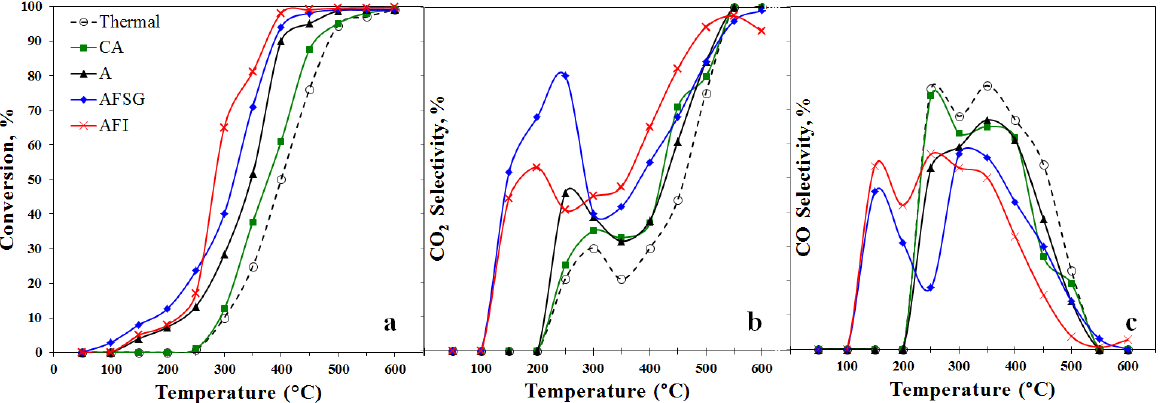
Figure 10. ( a ) Catalytic conversion, ( b ) selectivity toward CO